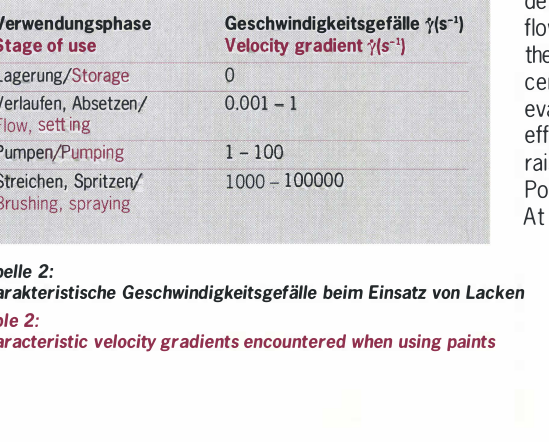
Table 2: Characteristic velocity gradients encountered when using